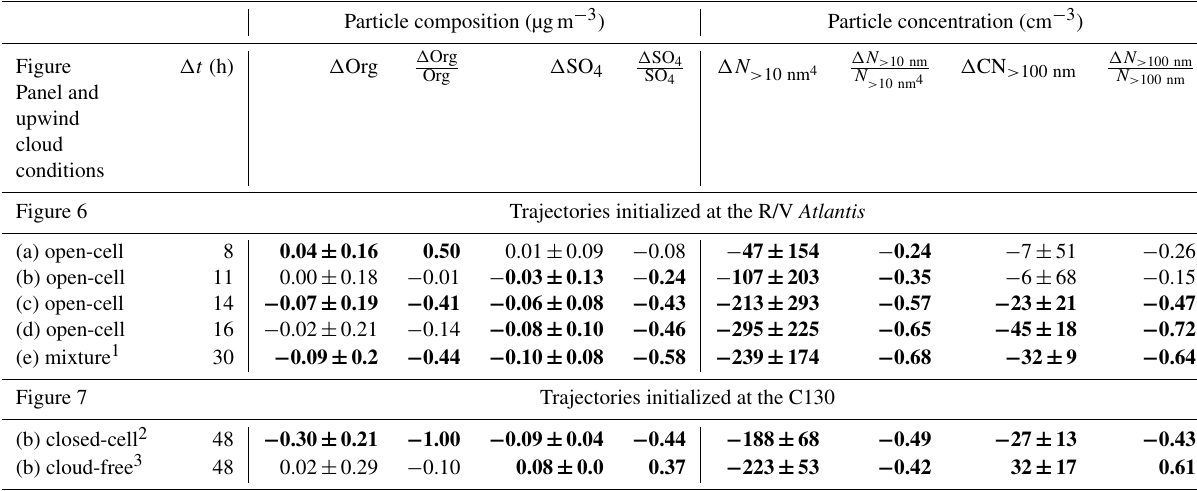
Table 3. The absolute and relative difference in aerosol between the downwind and upwind measurements for the cases in which 2d FLEXPART back trajectories initialized by the R/V Atlantis or C130 location overlap with upwind C130 measurement locations (within 1 ◦ latitude and longitude and 3h), shown in Figs. 6 and 7. The number of hours between the upwind and downwind measurements ( (cid:49)t ) are also included. R/V Atlantis measurements are derived from a 1h average. The difference in absolute values of the particle composition and concentration is calculated as an average ± 1SD. Values in bold indicate upwind and downwind measurement distributions are significantly different, assuming confidence interval of > 99%. The number of measurements used for each comparison, provided in Table S1, vary depending on sampling time and platform.